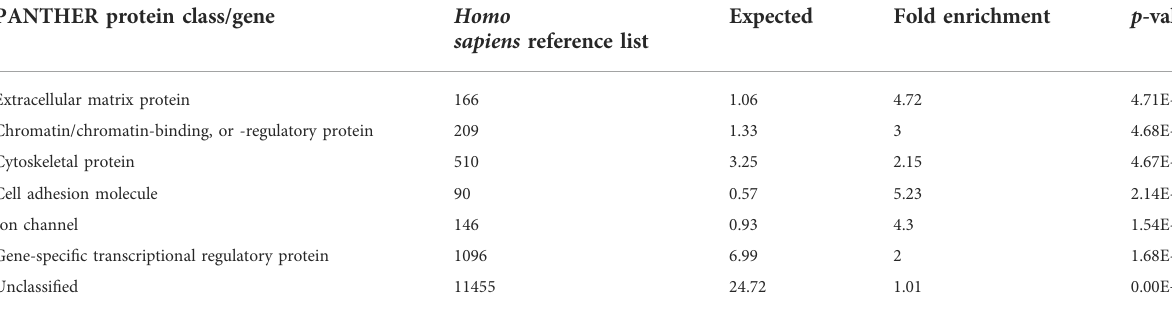
According to the PANTHER database system, various signaling pathways were signi fi cantly implicated in upregulated genes with log2 ratios > 4, which included 155 genes.